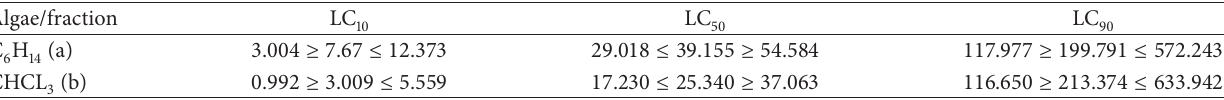
Table 1: Lethal concentrations (LC